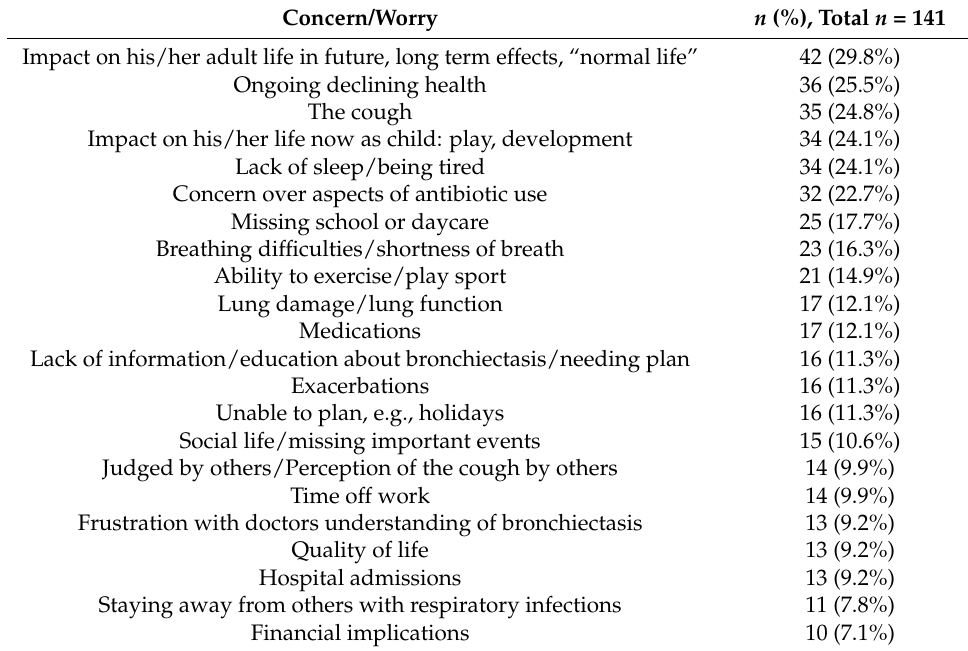
Table 3. Greatest concerns and worries voiced by parents of children with bronchiectasis 1